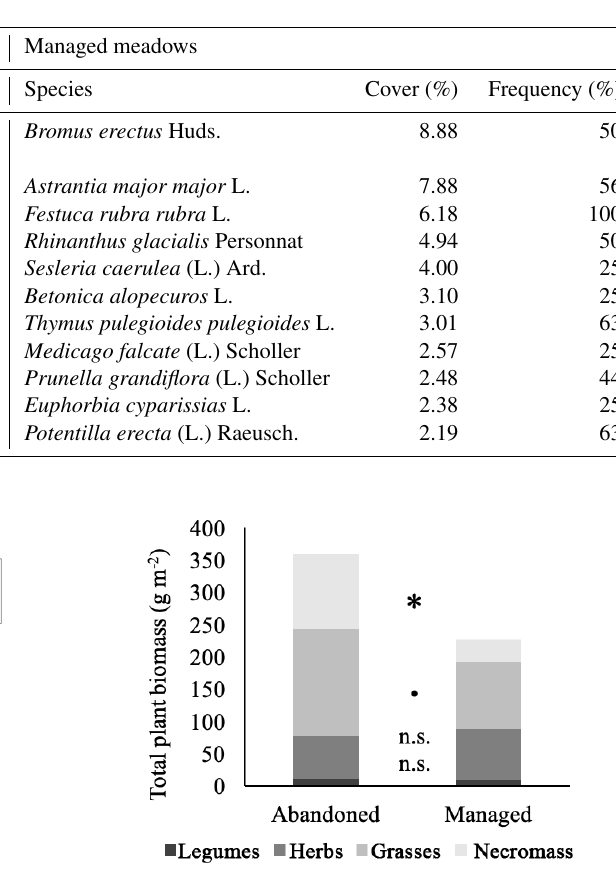
Figure 3. Structure of total plant biomass in abandoned and man- aged meadows. ∗ denotes significant difference between manage- ment types ( p < 0 . 05), • marginal difference ( p < 0 . 1), n.s. no sig- nificant difference. Values are